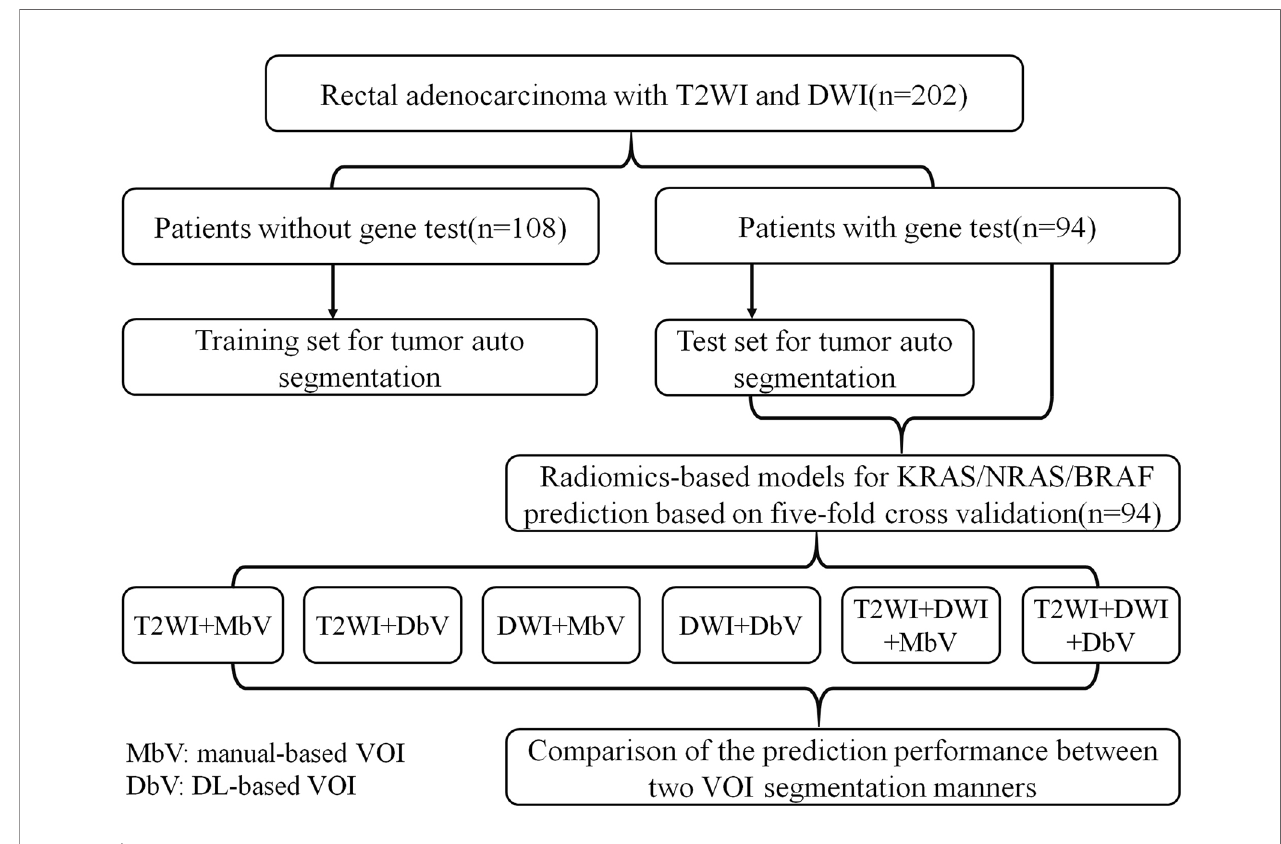
FIGURE 1 | Experiment fl ow chart. VOI, volumes of